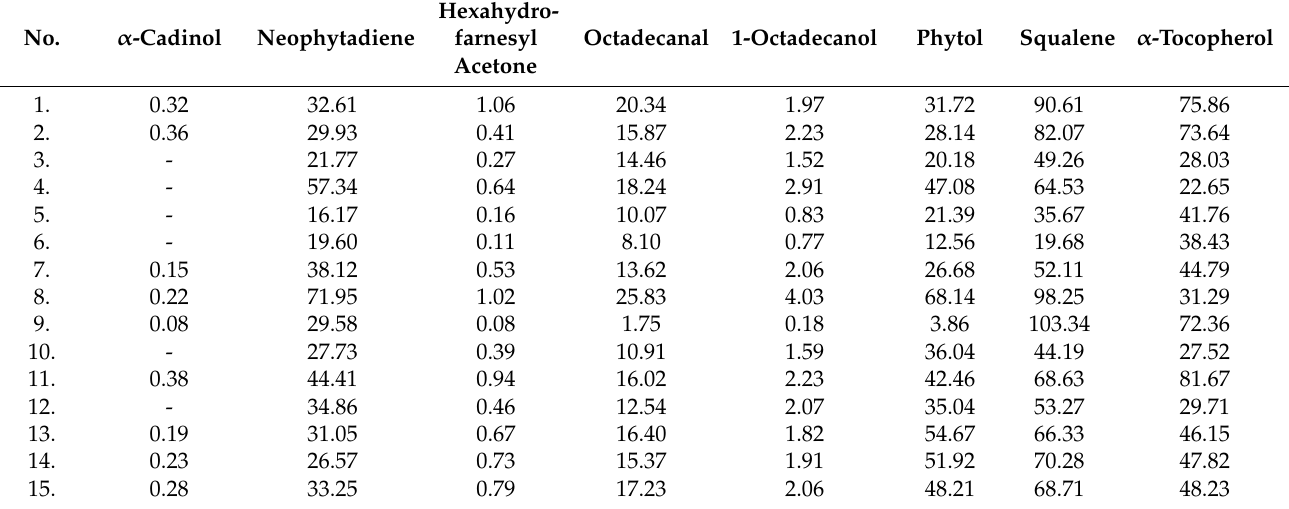
Table 2. The relative amount (in mg α -tocopherol equivalents per 100 g of dry leaves) of the phytochemicals in the SC CO 2 extracts of P. persica yellow